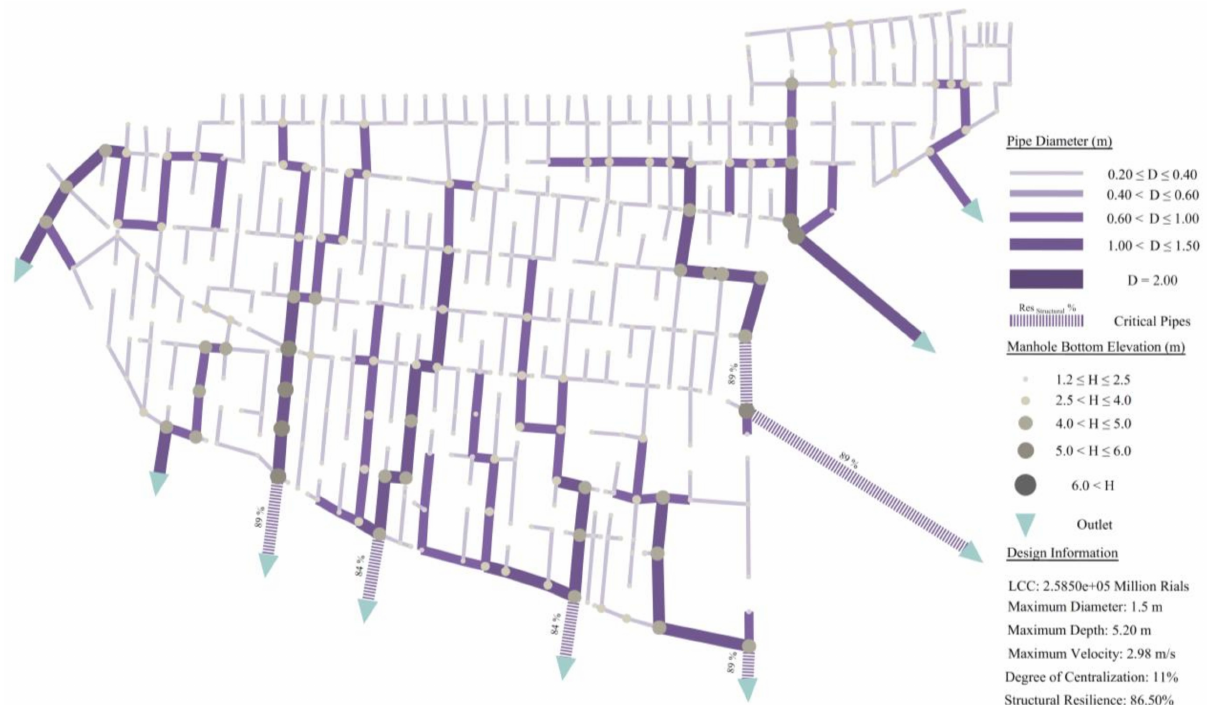
Figure 8. Design 2 (LCC = 258,500 M. Rials and DC = 11%).